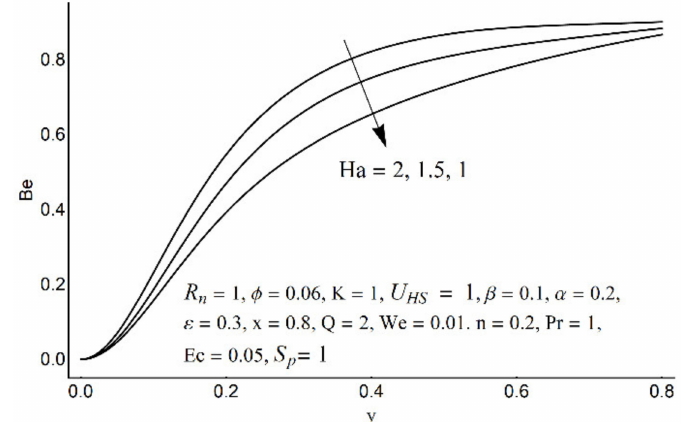
Figure 19. The Bejan number at various Ha.